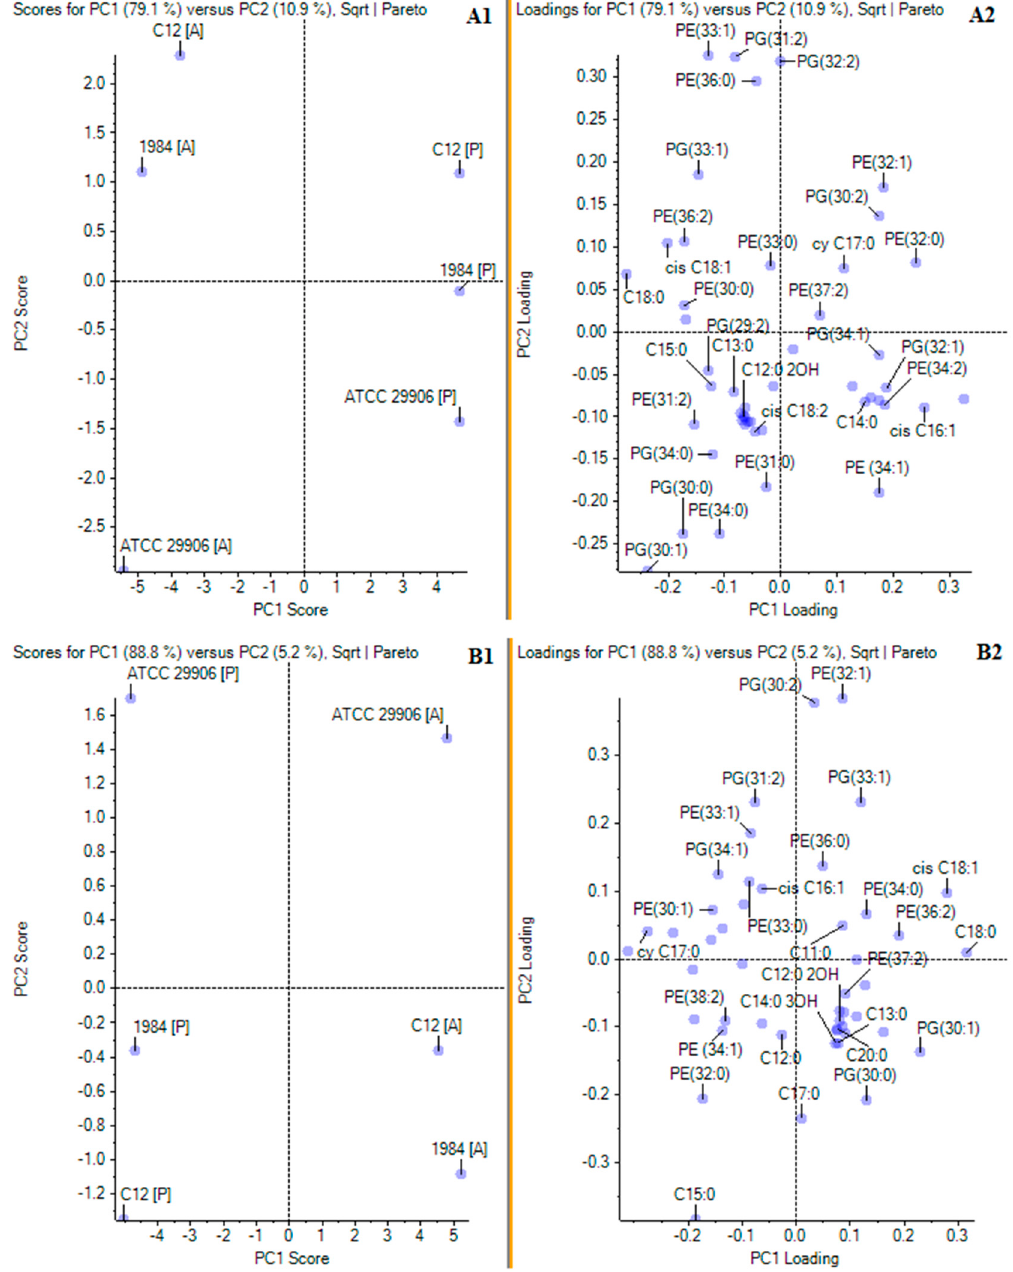
Figure 4. Principal component analyses of FA and PL profiles of planktonic and adherent cells of the studied P. mirabilis strains. Panels ( A1 , A2 ) and ( B1 , B2 ) present PCA for respectively 6 and 24 h P. mirabilis ATCC 29906, 1984 and C12 cells. Panels marked 1 ( A1 , B1 ) show PC1 and PC2 scores, while panels marked 2 ( A2 , B2 ) show PC1 and PC2 loadings.